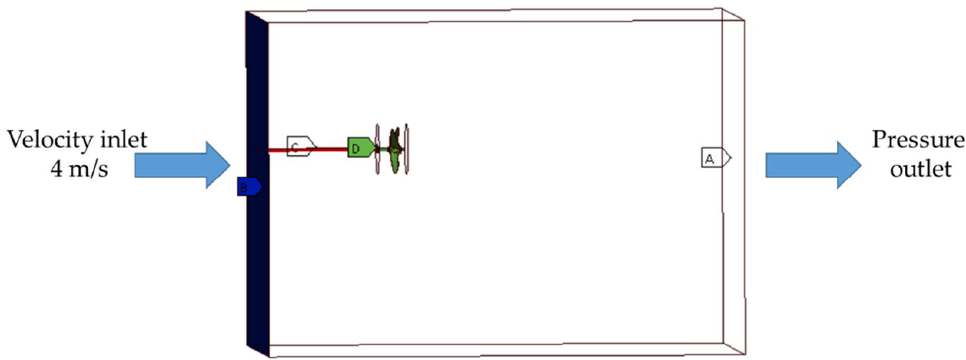
Figure 14. Boundary conditions.